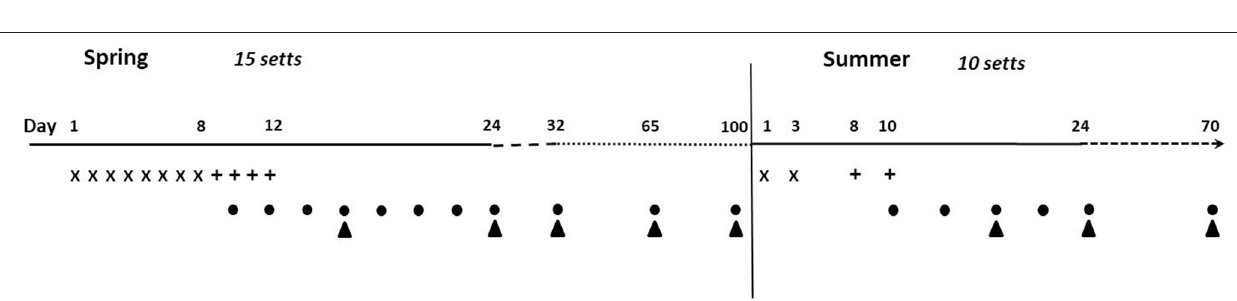
FIGURE 3 | Schedule for bait deployment and hair collection in spring (March to April 2018) and summer (July to August 2018). X , pre-baits deployment; + , baits deployment; • , hair collection near setts; N , hair collection on